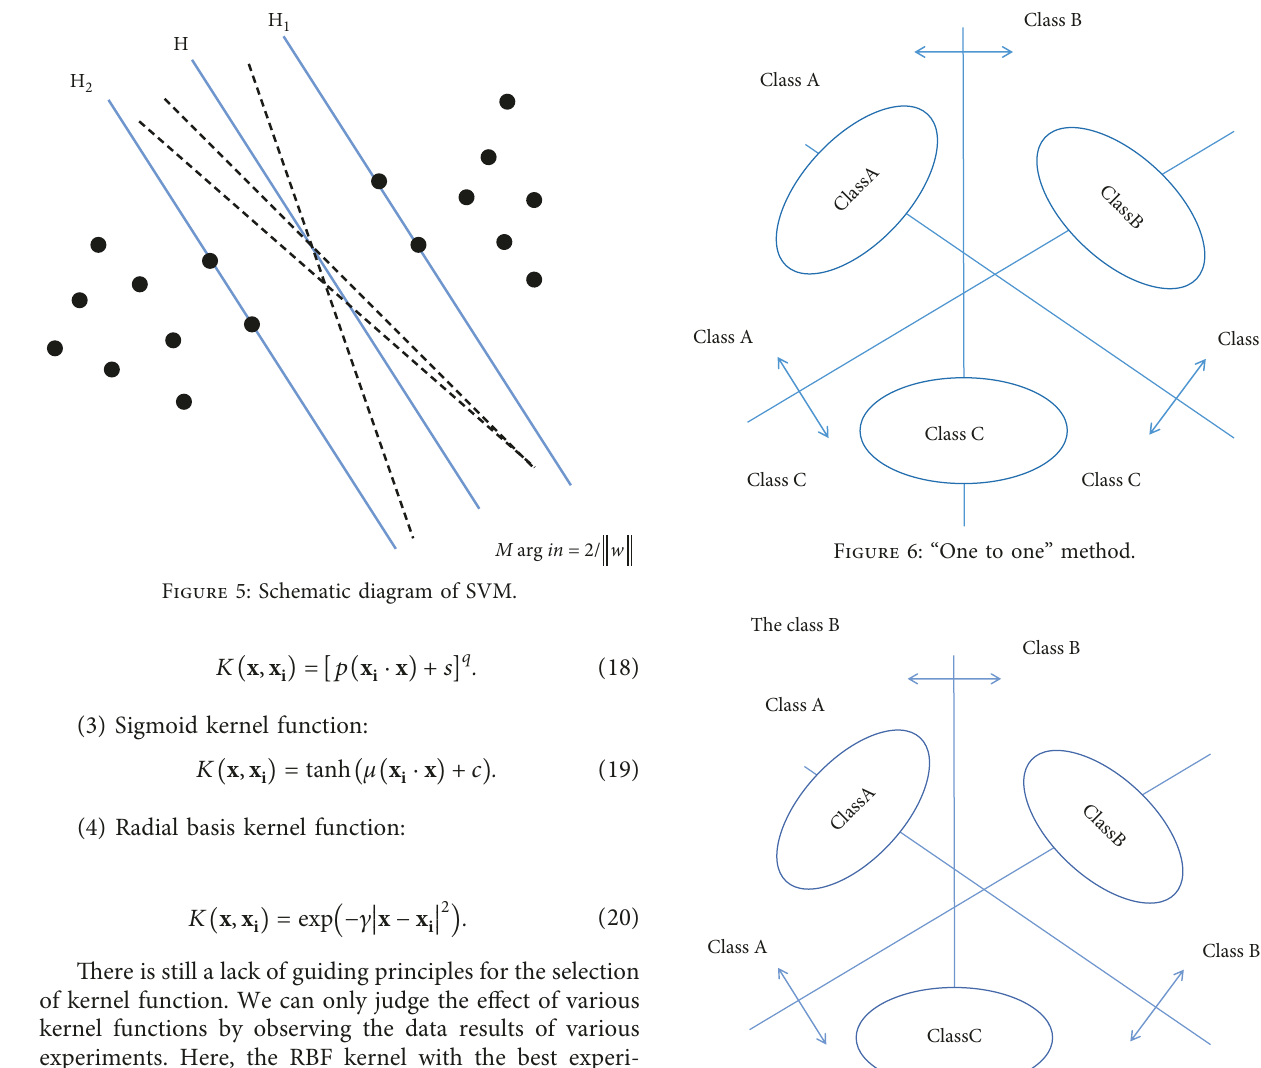
Figure 6: “One to one” method.